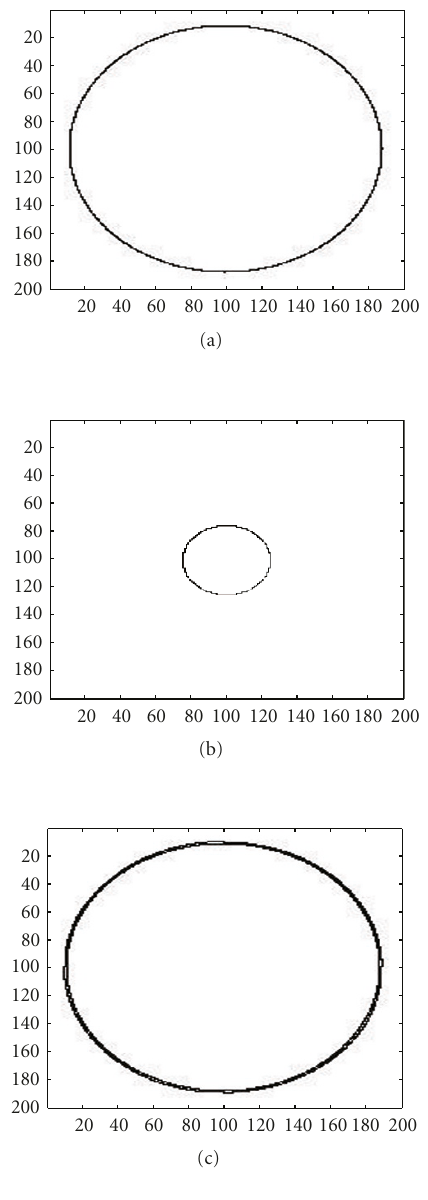
Figure 9: One circle: biased radius estimation, and application of gradient algorithm: (a) processed. (b) Initialization. (c) Superposi- tion processed and result obtained after applying gradient method: . 15 ME ρ = 0